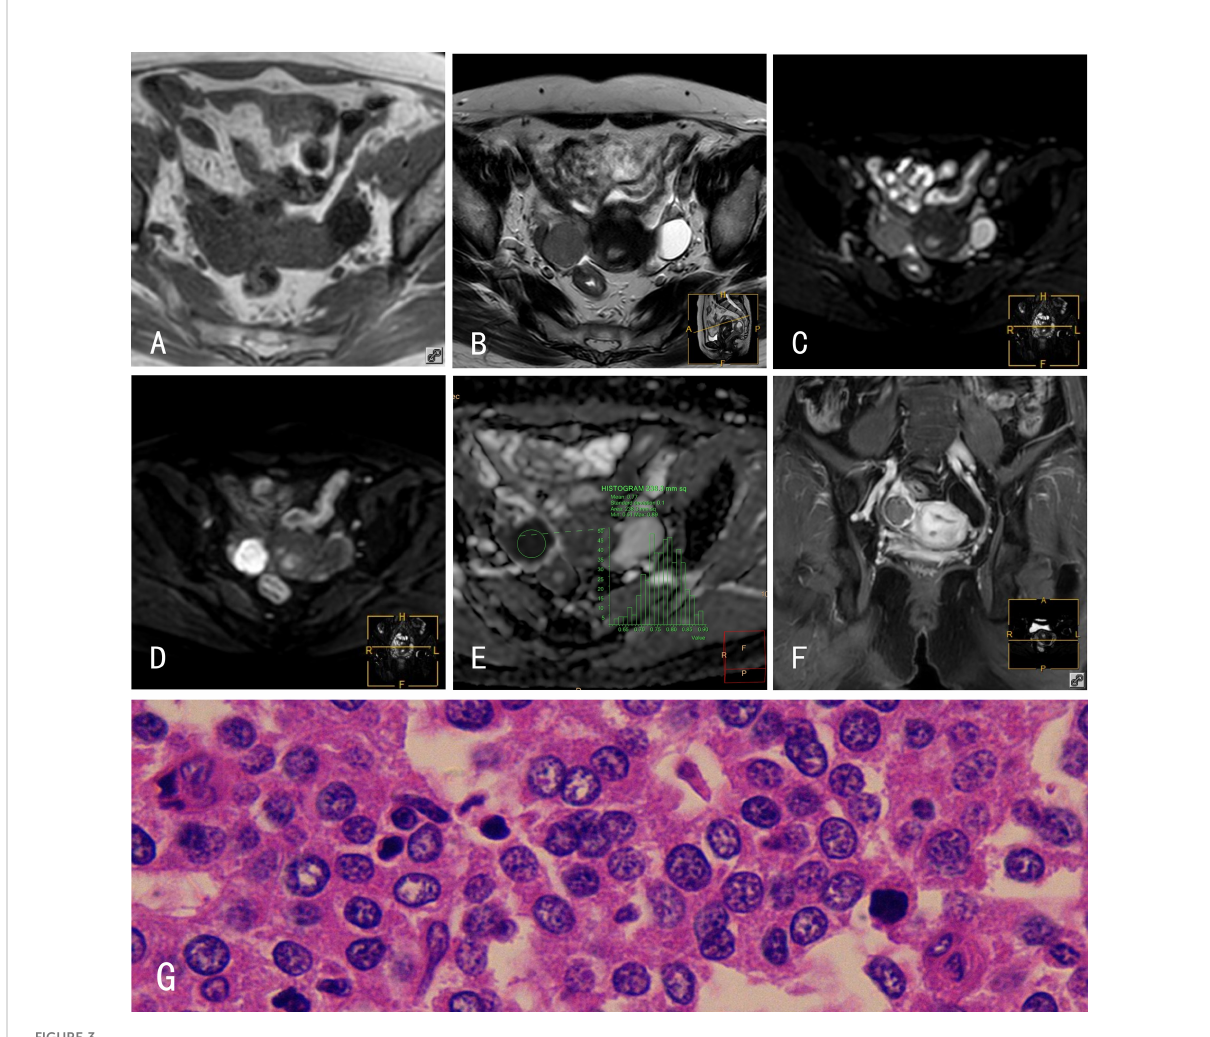
FIGURE 3 HGSOCs. 45-year-old female with a right HGSOC. (A) The HGSOC showed an isointense signal on mDIXON-T1WI; (B) slightly hyperintense signal on TSE-T2WI; (C) slightly hyperintense signal on TSE-T2WI-SPIR; (D) hyperintense signal on DWI (b=800s/mm 2 ); and (E) hypointense signal on the ADC map. (F) The HGSOC was slightly enhanced after Gd-DTPA administration. (G) Histological features of HGSOCs, HE×400; tumor cells are loosely arranged with some in mitosis. The glands are disordered with branching papillary structures and stromal in fi